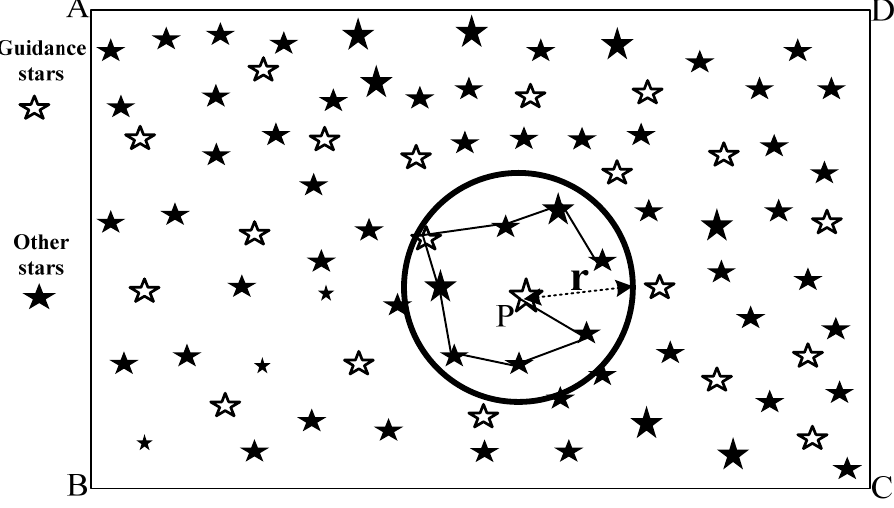
Figure 1. Schematic plan of the optimal path from path optimization using the AAC.